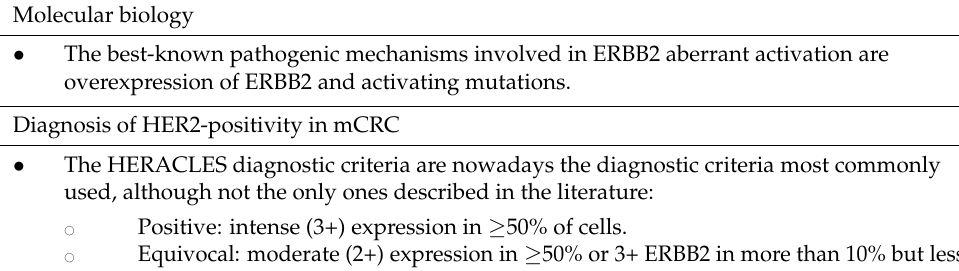
Table 3. Salient points of the